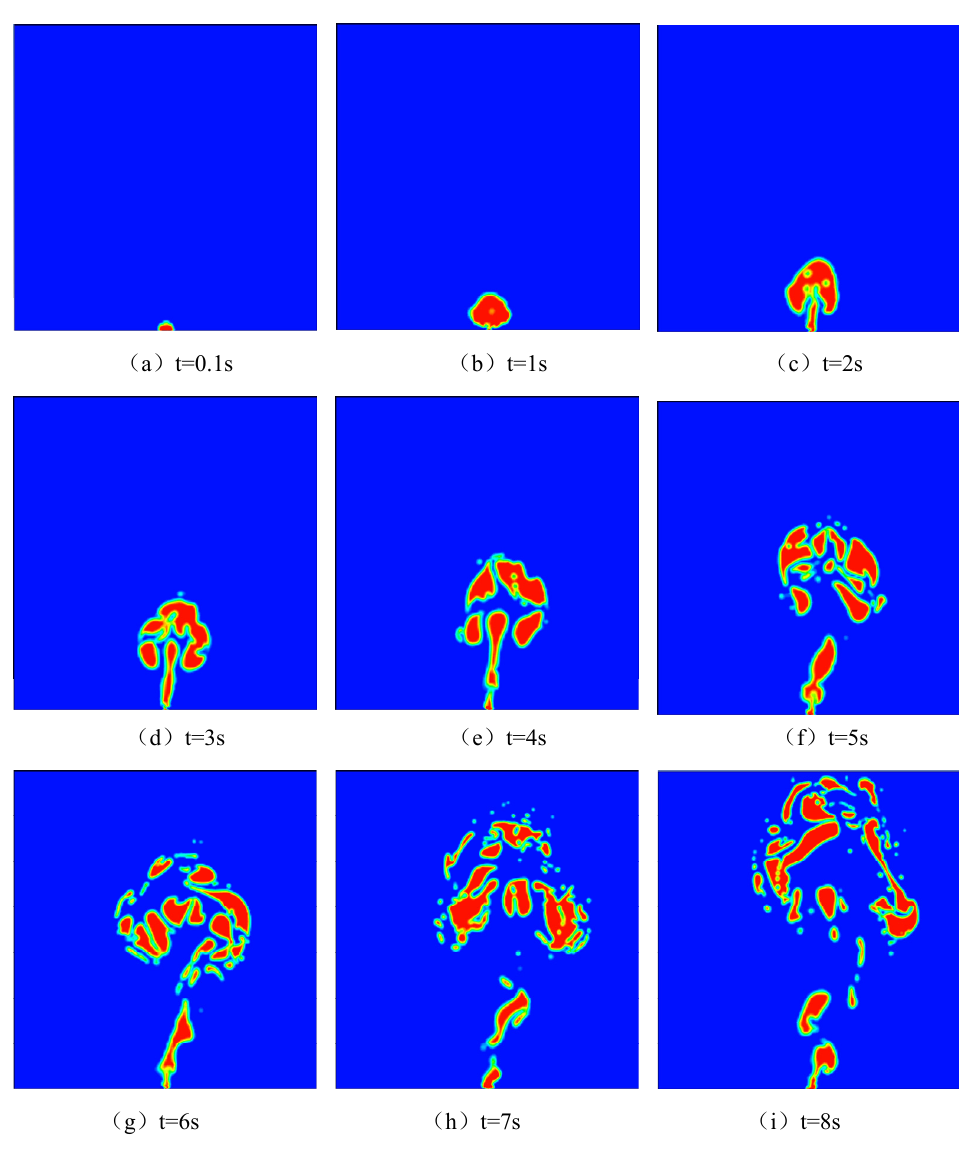
Figure 4. The whole process of gas release and dispersion from a submarine pipeline leak.